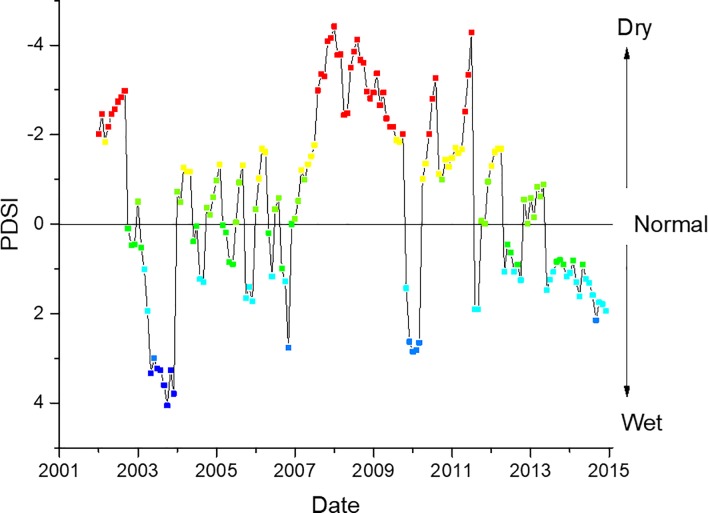
Palmer Drought Severity Index for the Neuse River Estuary during the course of the study.Scale is reversed with negative (dry) values being the topmost part of the graph. Colors added to aid in visualization of drought index severity.